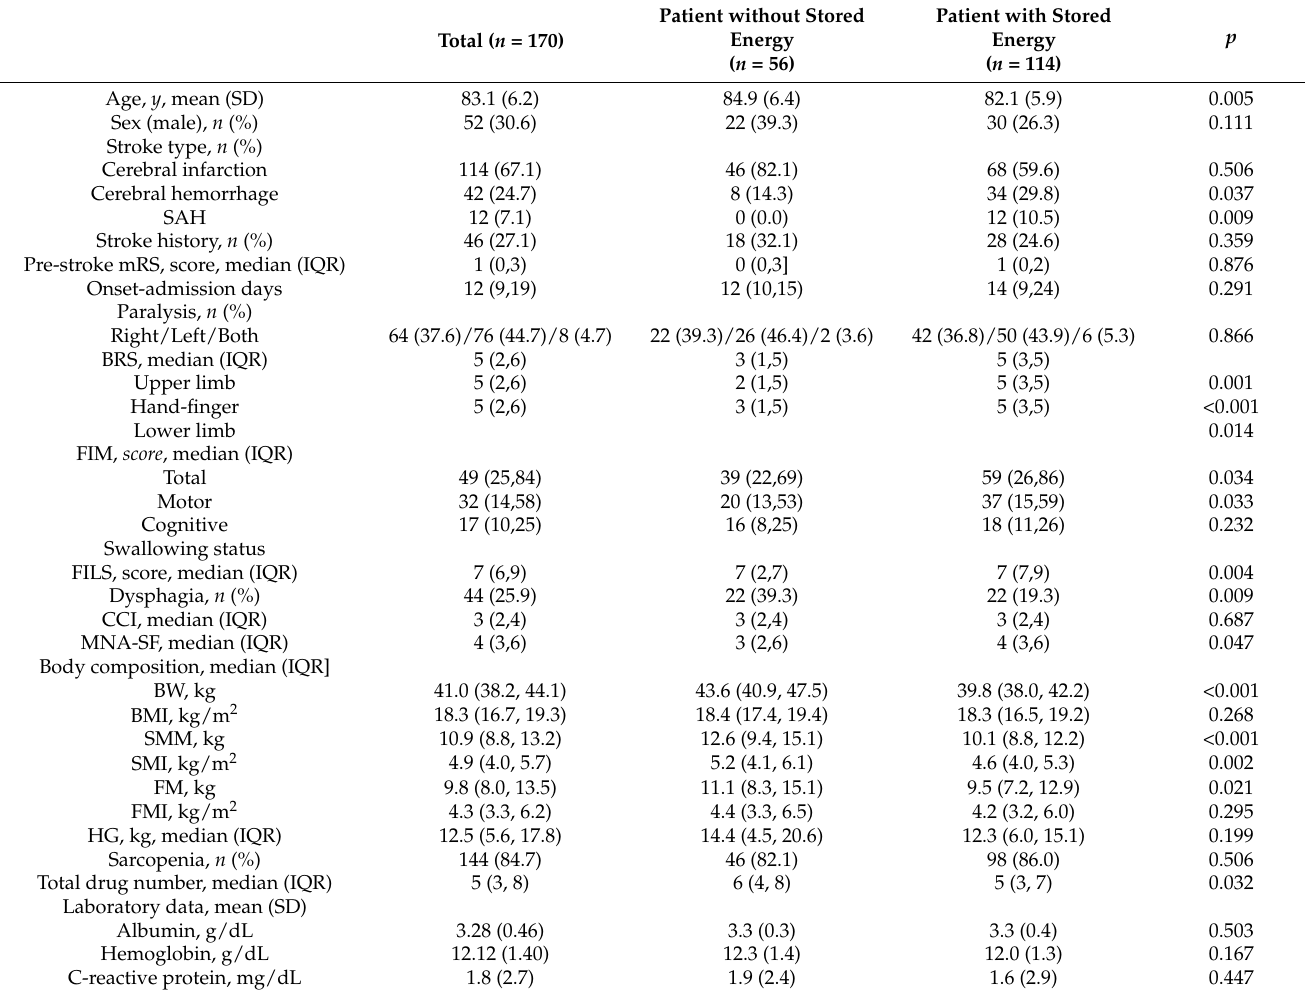
Table 1. Baseline patient characteristics and between-group characteristics of patients with and without stored energy intake.